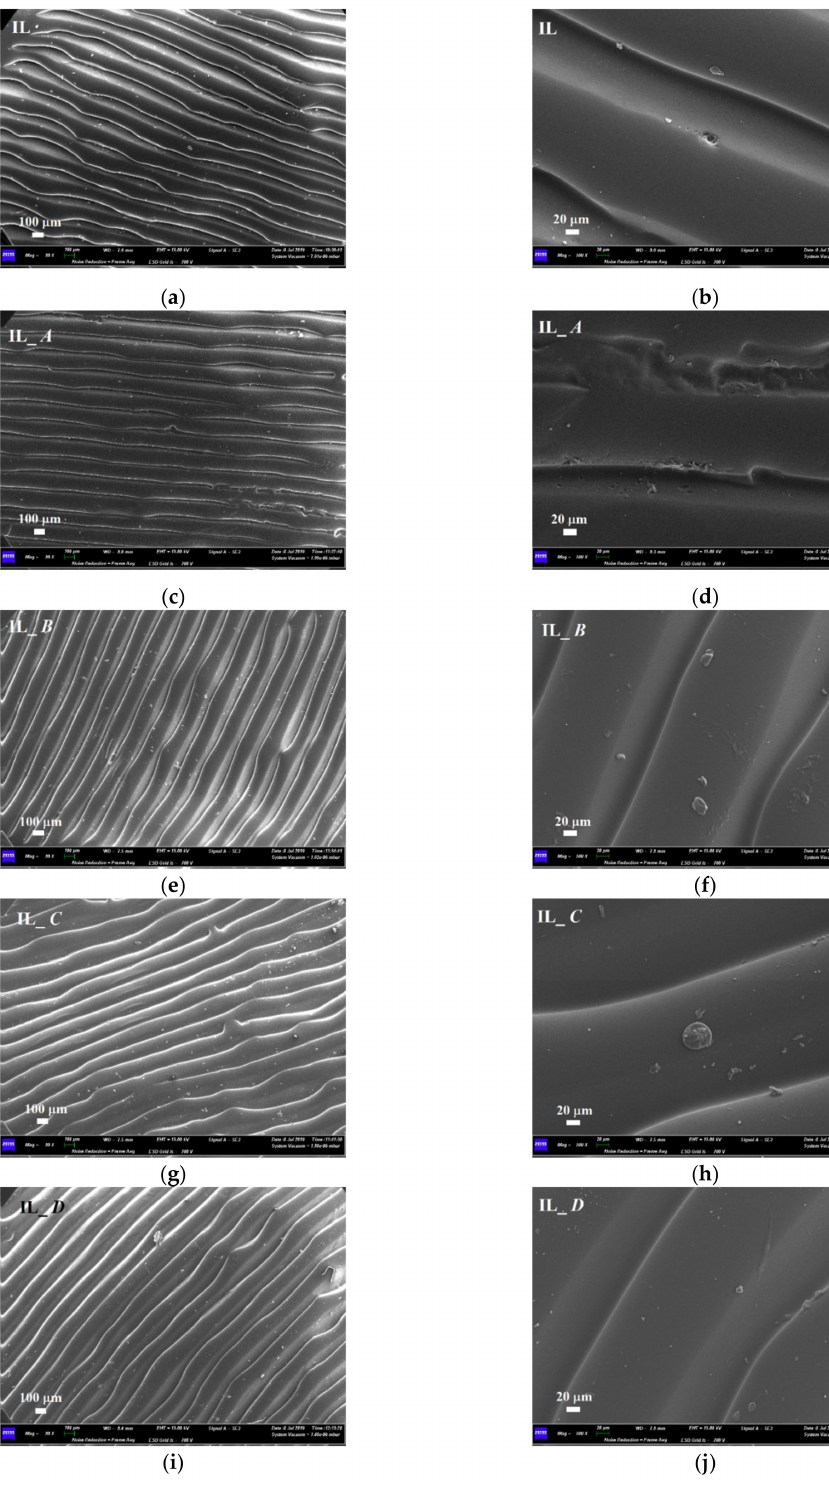
Figure 11. Comparison between SEM micrographs of Invisalign (IL) aligner before and after 2 weeks of immersion into staining beverages; ( a , b ) as-received sample; ( c , d ) sample immersed into artifi- cial saliva (A); ( e , f ) sample immersed into nicotine (B); ( g , h ) sample immersed into red wine (C); ( i , j ) sample immersed into coffee